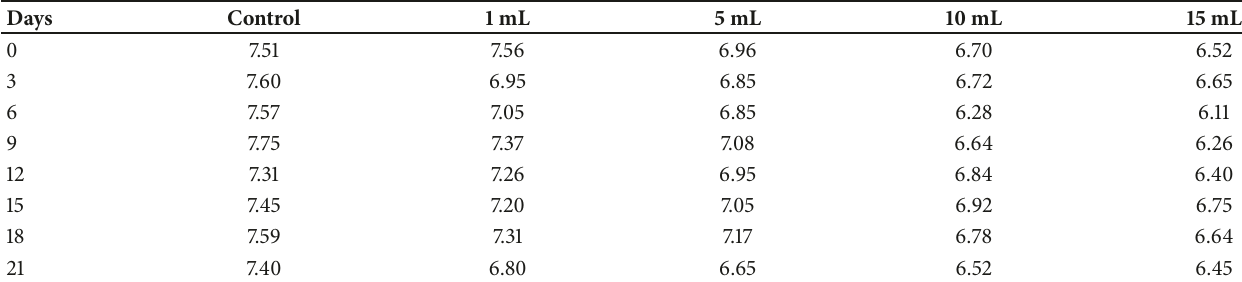
Table 3: pH values for cathodic protection and different volumes of oil extract for steel with zinc in seawater.